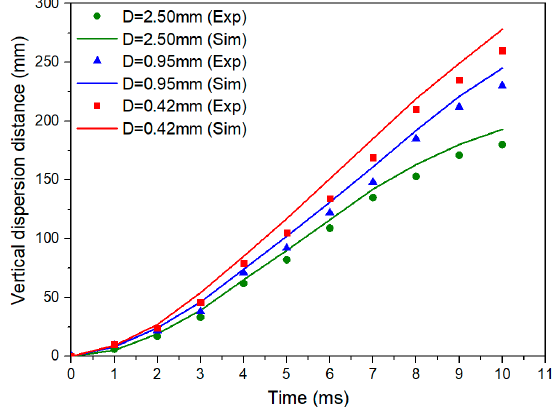
Figure 13. Particle vertical dispersion distance at different times.